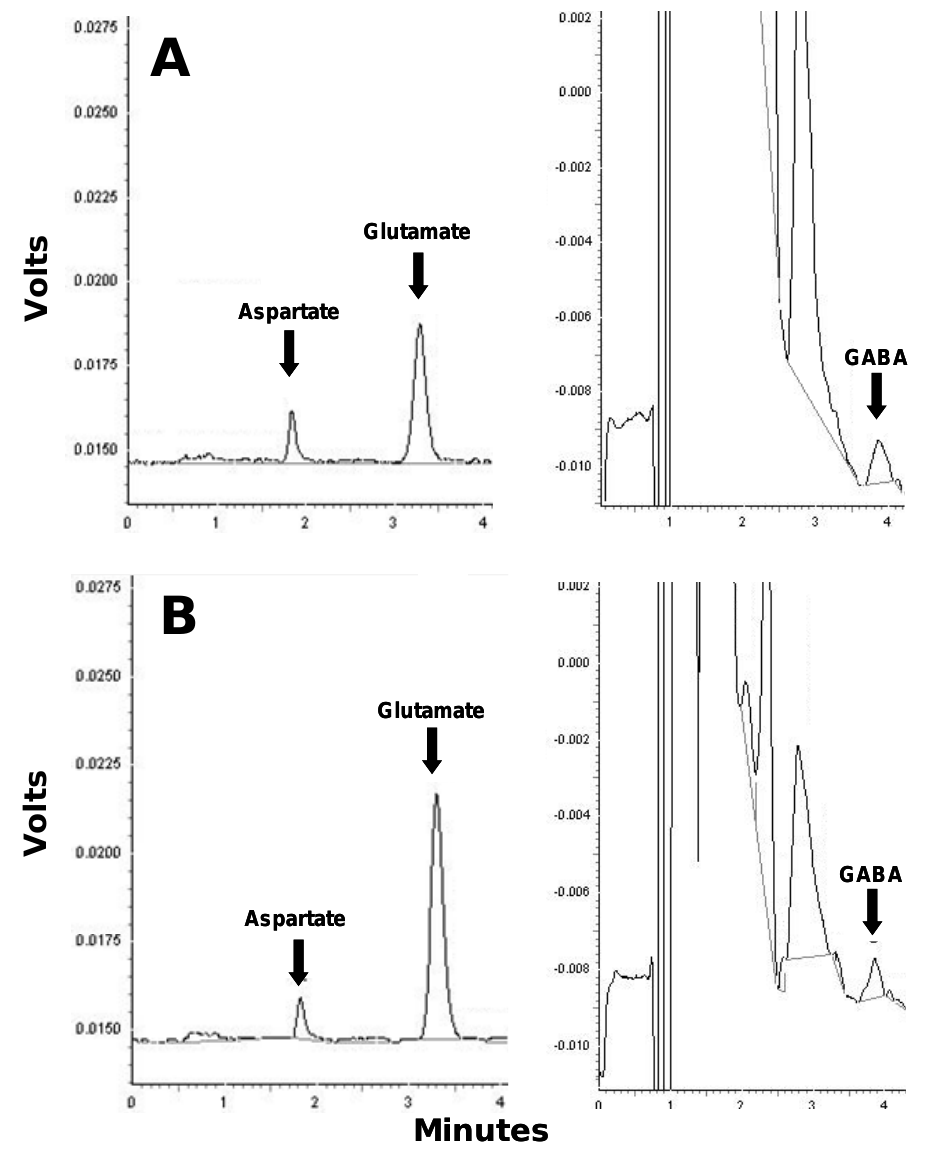
Figure 3. Sample high performance liquid chromatograms of glutamate and aspartate (left) and GABA (right) from 20 min dialysate samples collected from the dorsal hippocampus of the awake rat (A) 20 min prior to (basal) and (B) 200min following an ipsilateral icv injection of the A 